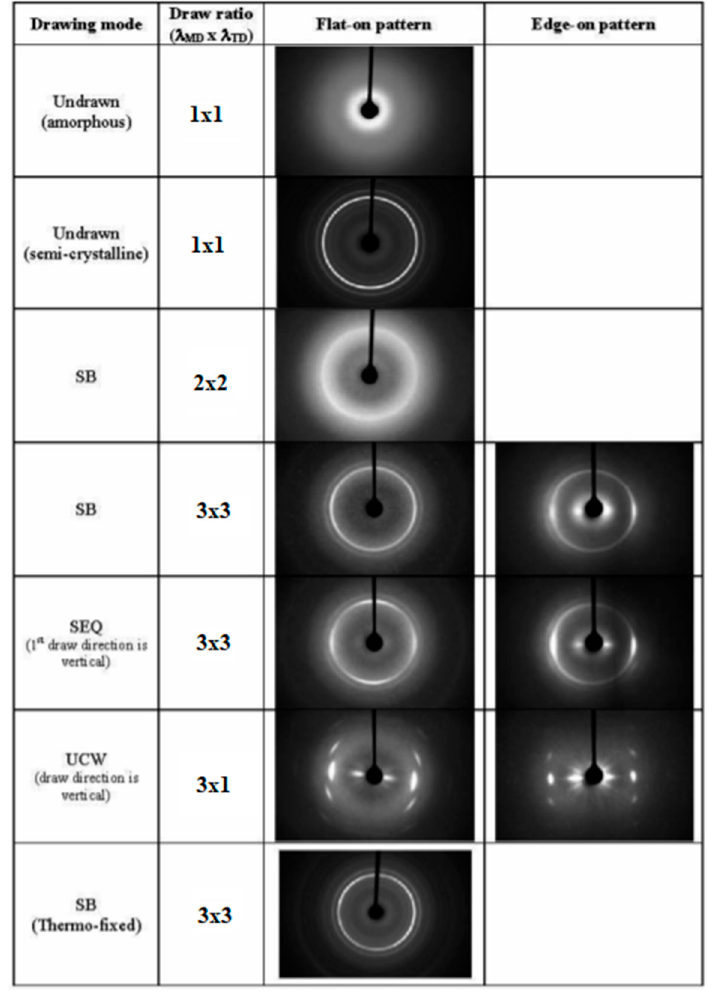
Figure 4. WAXD patterns of drawn and thermally crystallized PLA films. Adapted from [62] with permission from American Chemical Society. Copyright © 2012.